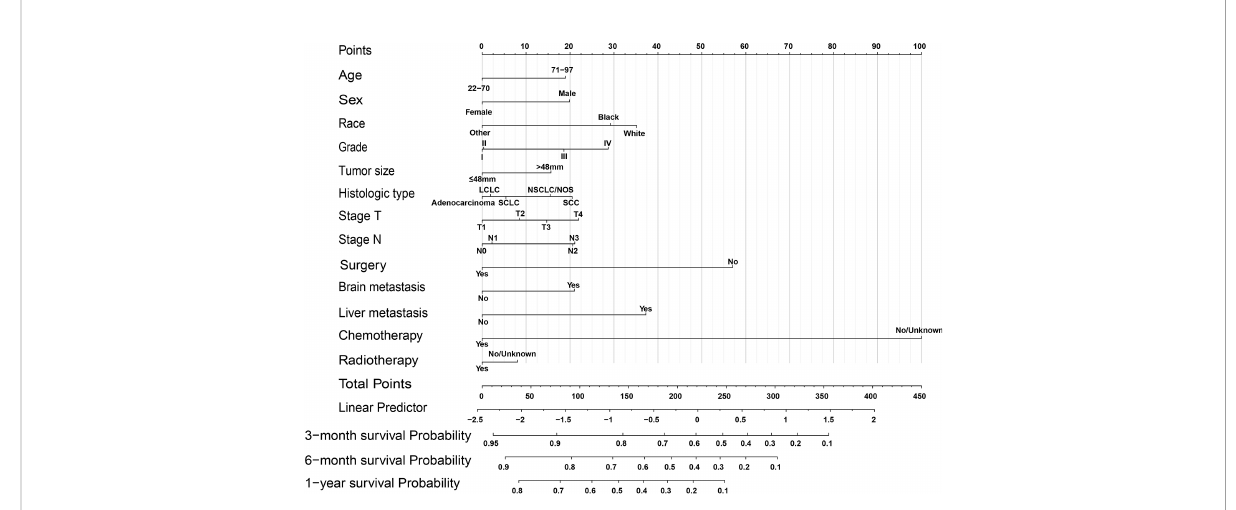
FIGURE 2 OS nomogram for lung cancer with bone metastasis. SCC, squamous cell carcinoma; SCLC, small cell lung cancer; LC, large cell; NSCLC/NOS, non-small cell lung cancer/not otherwise speci fi